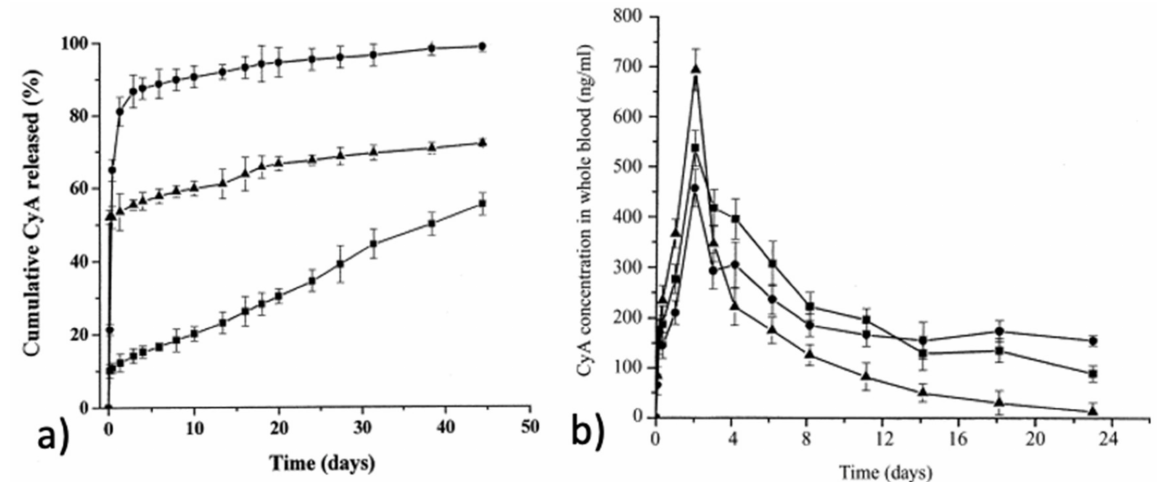
Figure 16. ( a ) In vitro release profiles of cyclosporin A-loaded microspheres in 0.1 M phosphate buffer solution (pH 7.4, containing 0.2% SDS) at 37 ◦ C. ( • ) CyA-P(LA-b-CL) (48.1/51.9); ( b-CL) (78.7/21.3) and ( (cid:4) ) CyA-PLGA (80/20). ( b ) In vivo release profiles of cyclosporin A-loaded microspheres (suspended in 1 mL of 0.1% CMC-Na) after subcutaneously injected into Wistar